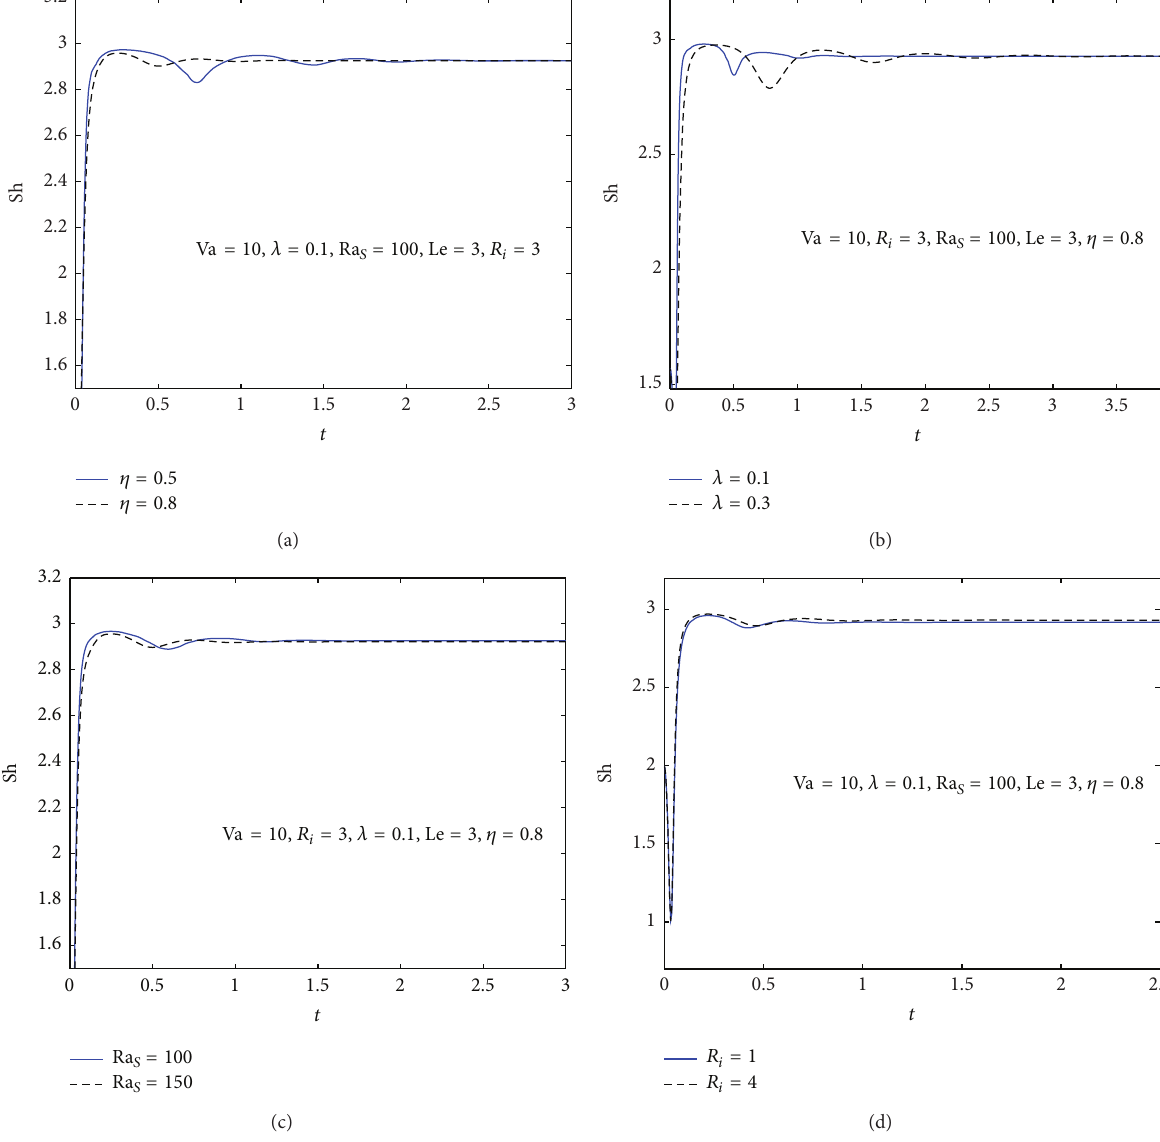
Figure 4: Variation in Nusselt number Sh with respect to time 𝑡 for unsteady nonlinear stability at different values of